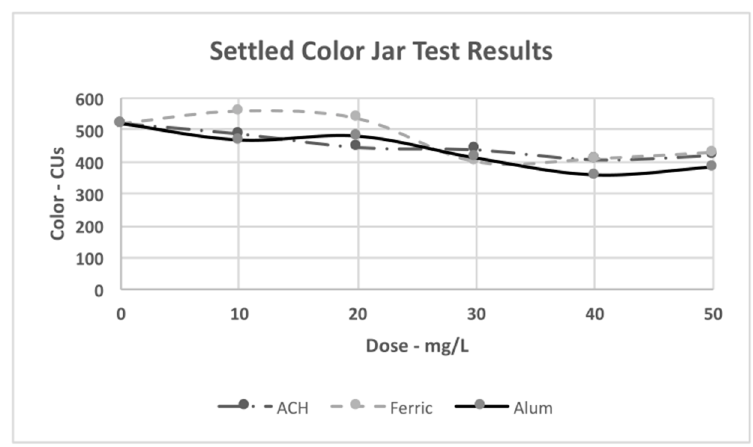
Figure 6. Jar test settled alkalinity versus coagulant dose.